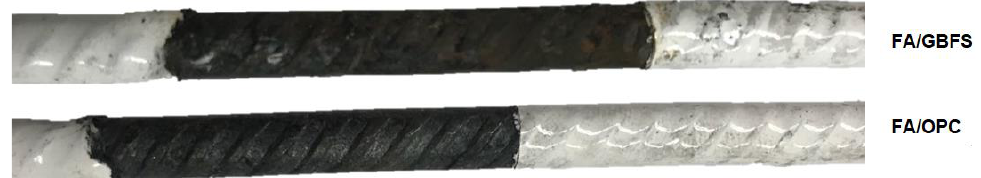
Figure 12. Photographs of reinforcing steels extracted from FA/GBFS and FA/OPC concretes, at the end of exposure to a 3.5% NaCl solution.